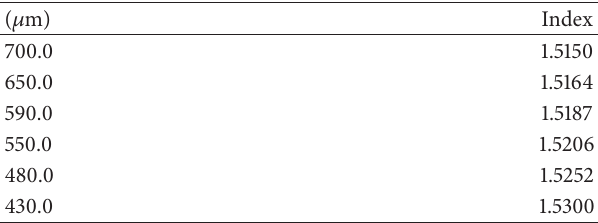
Table 1: The refractive index of Glass 1 and Glass 2 [19].